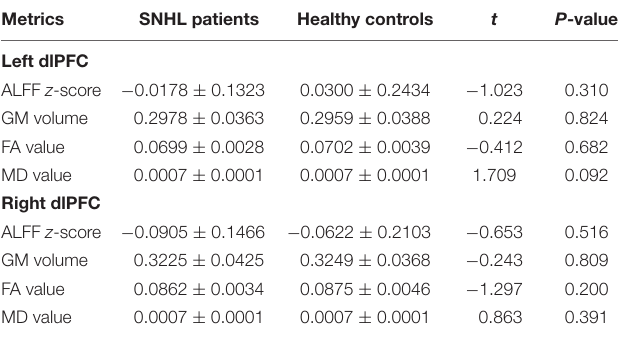
TABLE 3 | Multimodal measurements of the bilateral dlPFC.